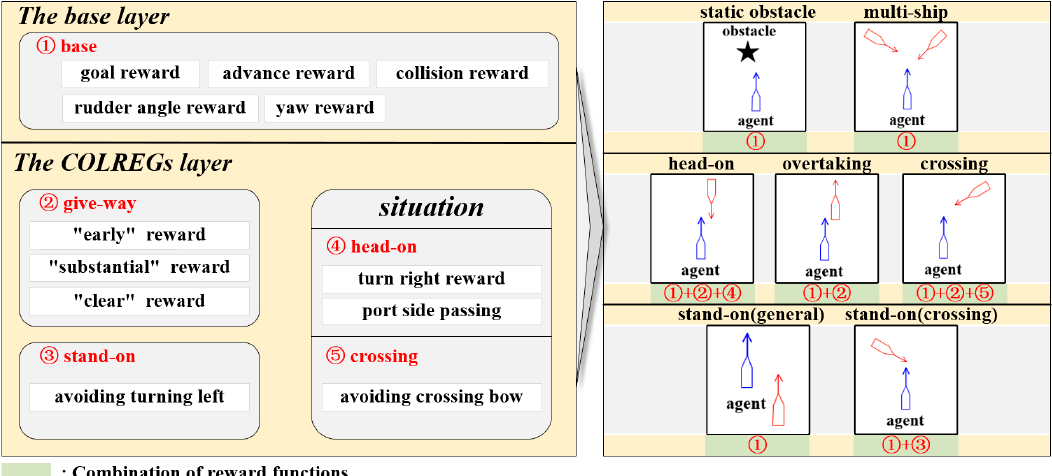
Figure 6. Definition of the reward function and the combination of the reward function in different encounter situations.